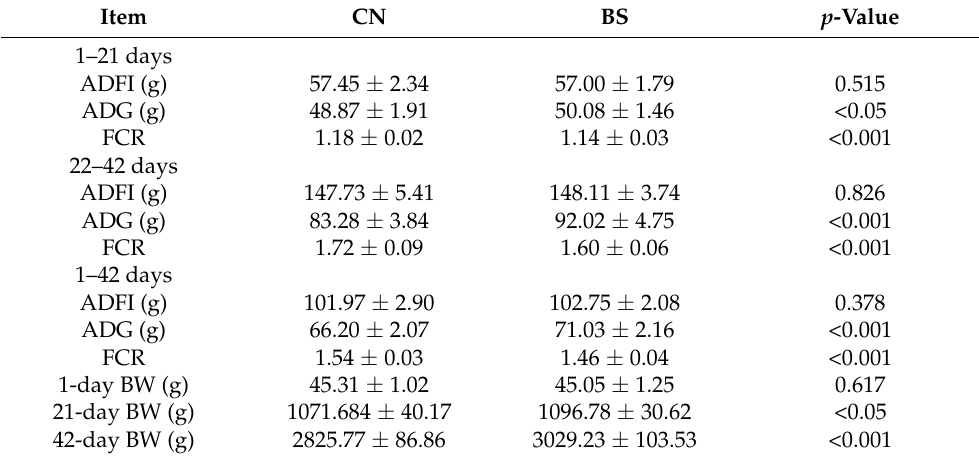
Table 2. Effects of dietary Brevibacillus laterosporus S62-9 on the meat quality of chicken meat.